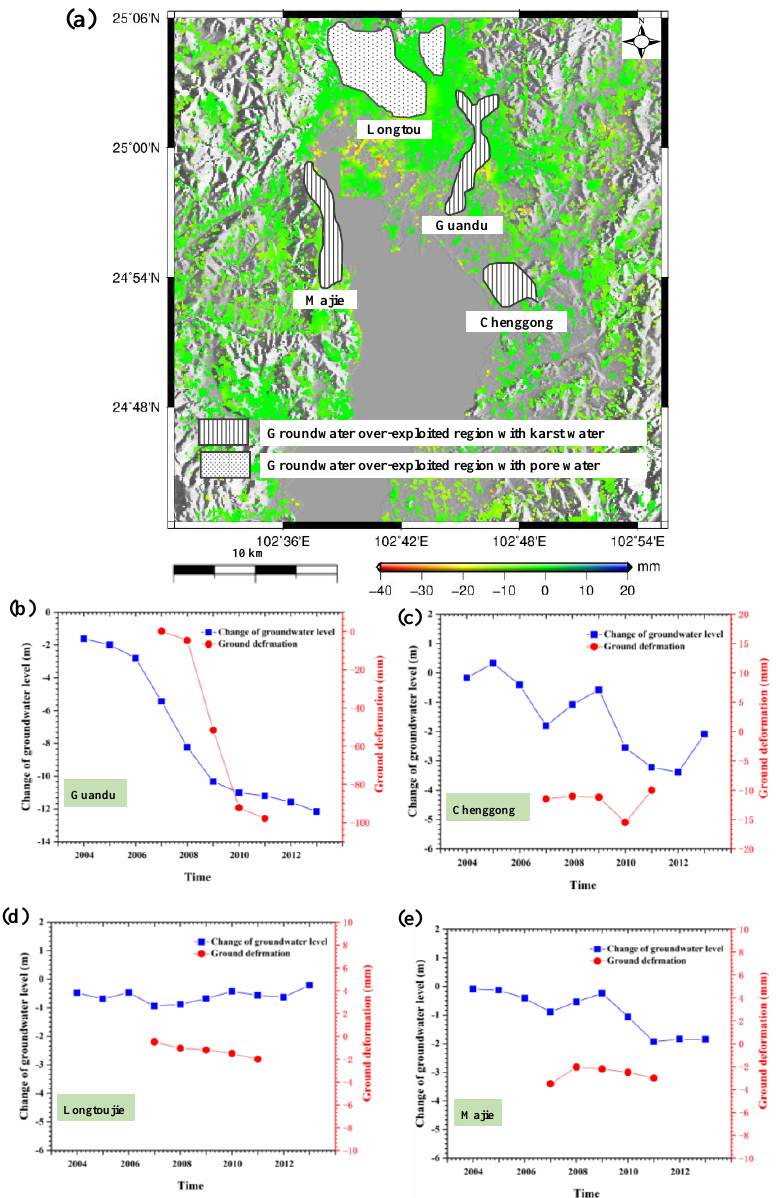
Figure 22. The distribution of groundwater exploited regions in Kunming ( a ) and relationship between annual changes of groundwater level and ground deformation in Guandu ( b ), Chenggong ( c ), Longtoujie ( d ), and Majie ( e ). The ground deformation is derived from L-band ALOS-1.